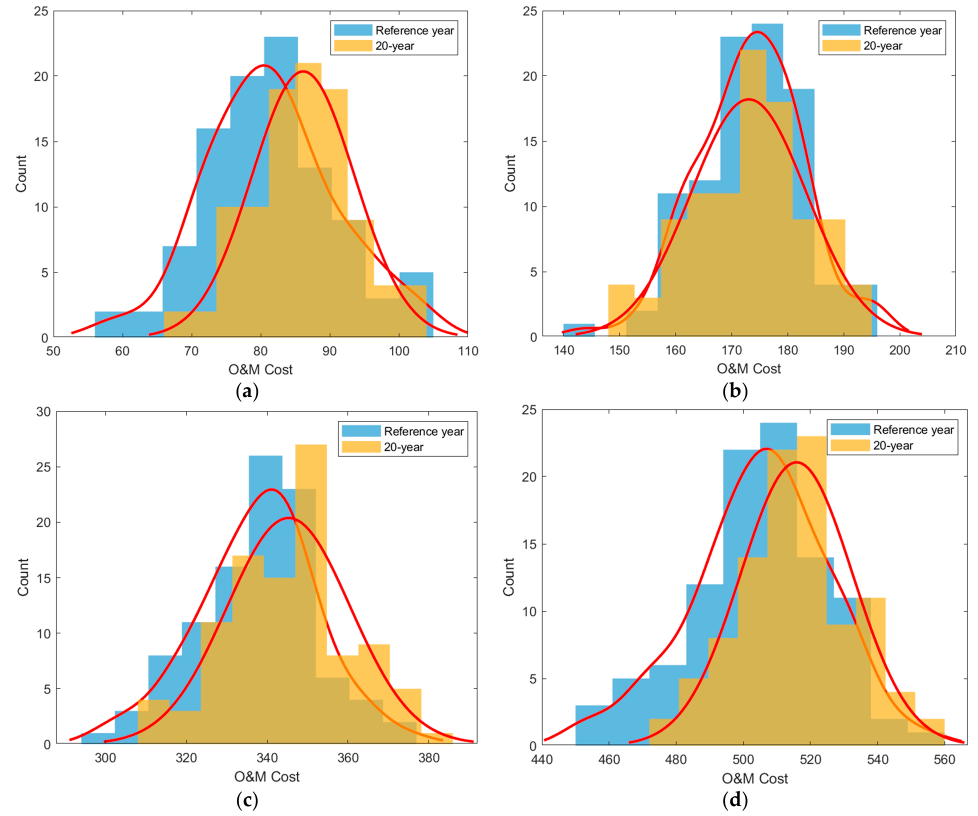
Table 6. Wilcoxon rank sum test results for lifetime O&M cost and lifetime energy production.